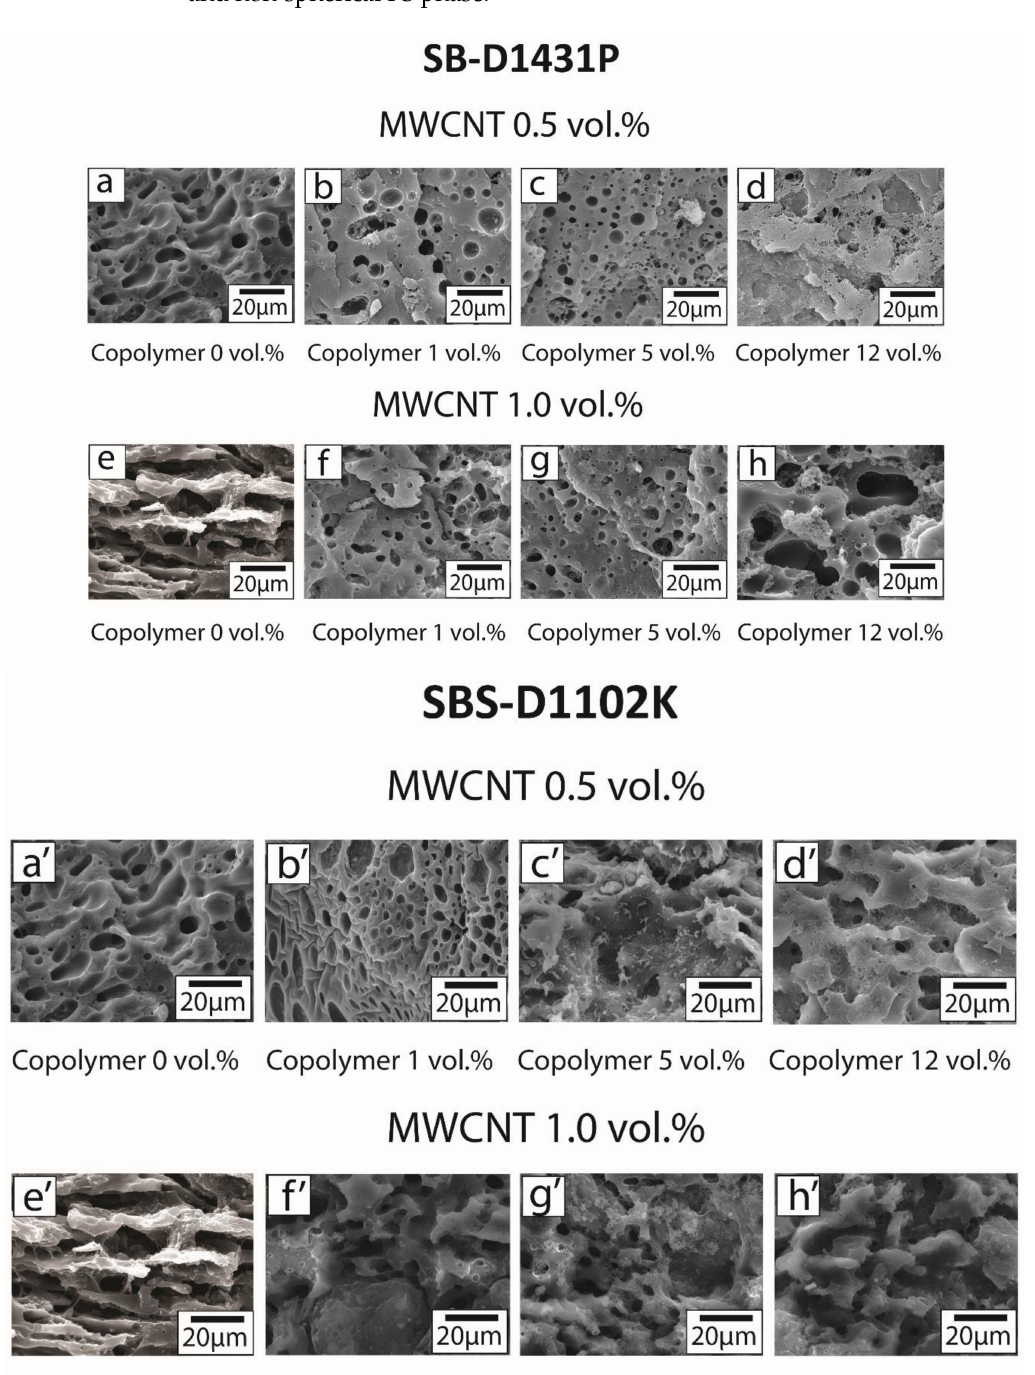
Figure 6a’,e’, and Figure 6a”,e”) in the absence of block copolymers displayed a deformed and non-spherical PS